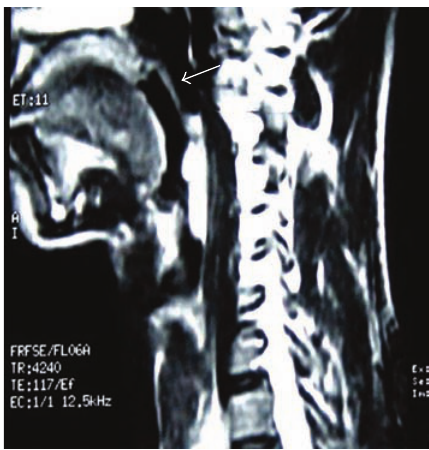
Figure 2: A T2-weighted MRI sagittal image showing the tonsillar polyp with the stalk arising from the inferior pole of the tonsil and extending posterior to the epiglottis and into the postcricoid region with partial occlusion of the glottis.